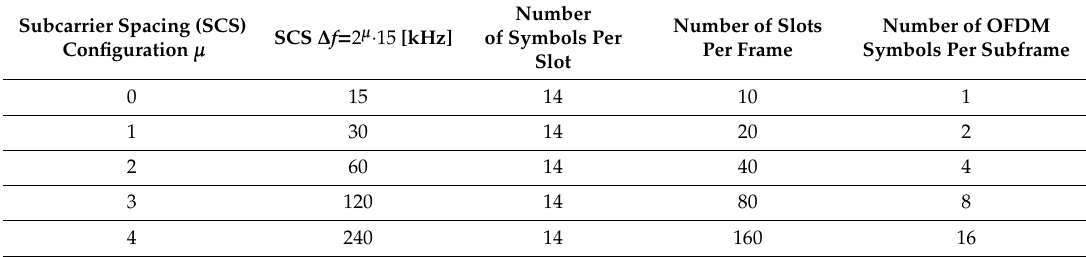
Table 2. Orthogonal frequency division multiplexing (OFDM) symbols configuration in 5G NR [26].